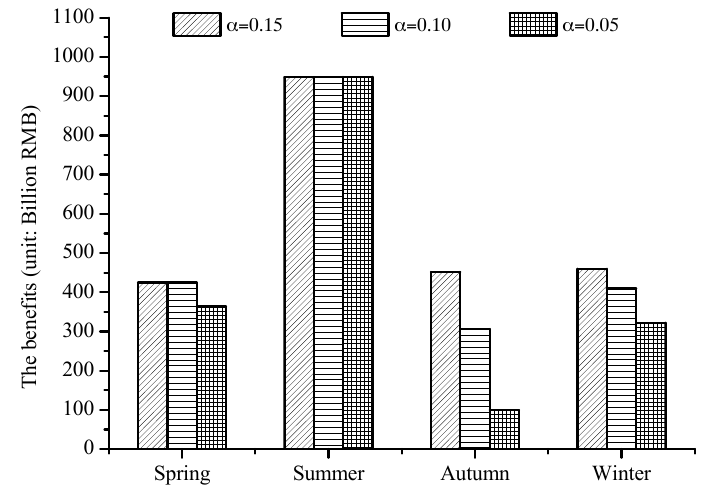
Figure 8. The economic benefit of three industries in different seasons under different violating constraints.